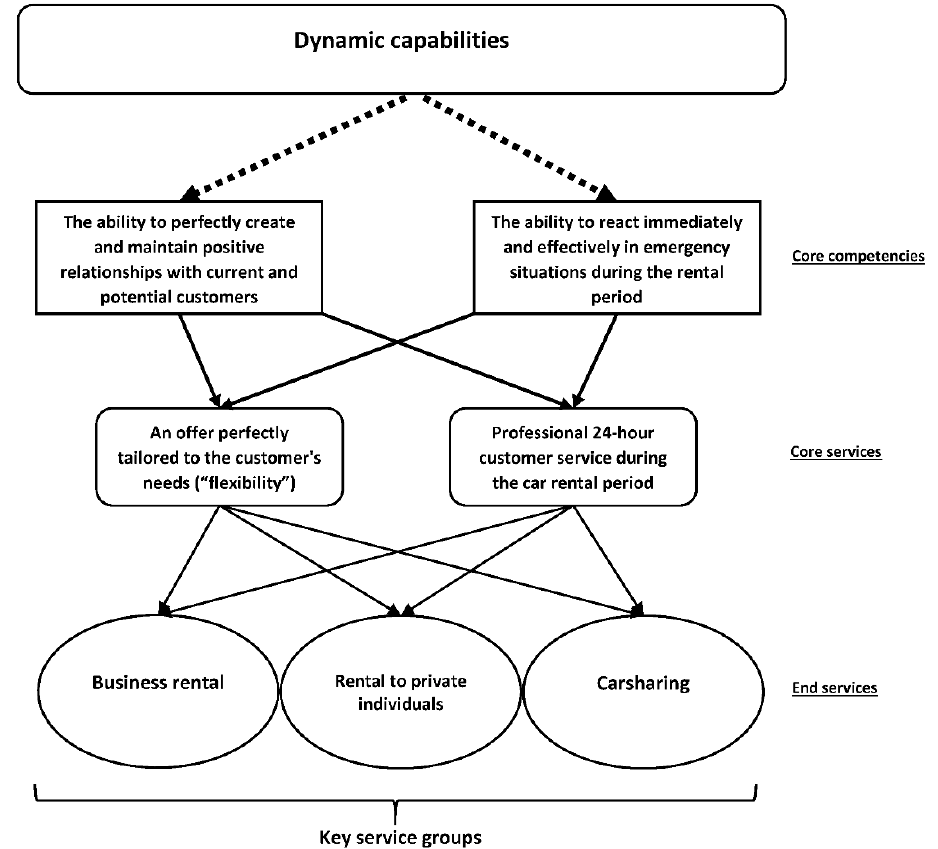
Figure 4. Relationships between dynamic capabilities, core competencies, core and end services of Panek S.A.